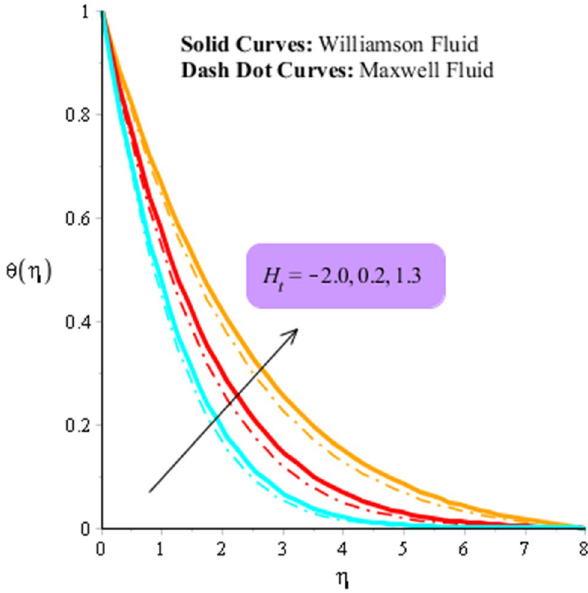
Figure 10. Influence of H t versus temperature filed.